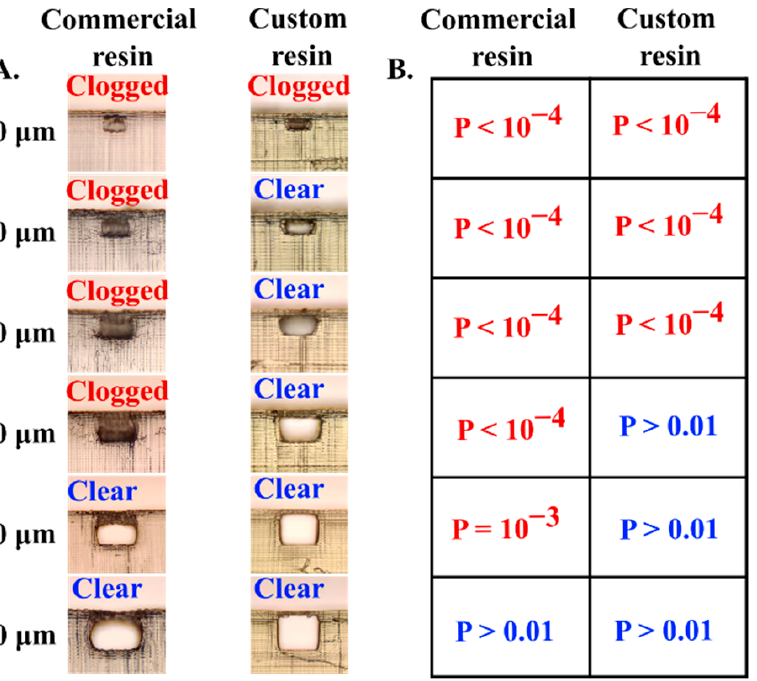
Figure 4. ( A ). Cross-sectional profile of embedded square channels) printed from commercial and custom resin (1% NPS) formulation to characterize successful and unsuccessful prints. 9 replicates were performed for each channel cross-section ranging from 50–600 µ m. ( B ). Corresponding p values from a z-test (single tail) were calculated to determine the statistically reliable probability of printing clear unclogged channels [Null-hypothesis: The SLA resin can print microfluidic channels with unclogged embedded hollow channels with reproducibility of >90%; Criterion for rejection of; p value <0.01].